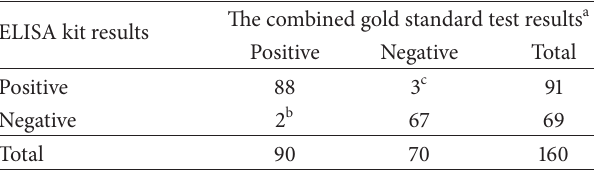
Table 1: The ELISA kit’s results compared to the assembled gold standard test’s results.